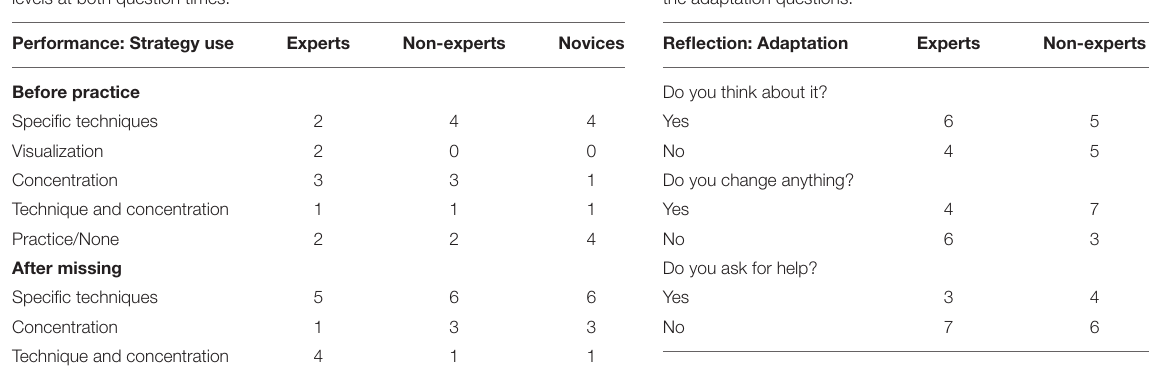
TABLE 9 | The number of people in each group who said yes and no for each of the adaptation